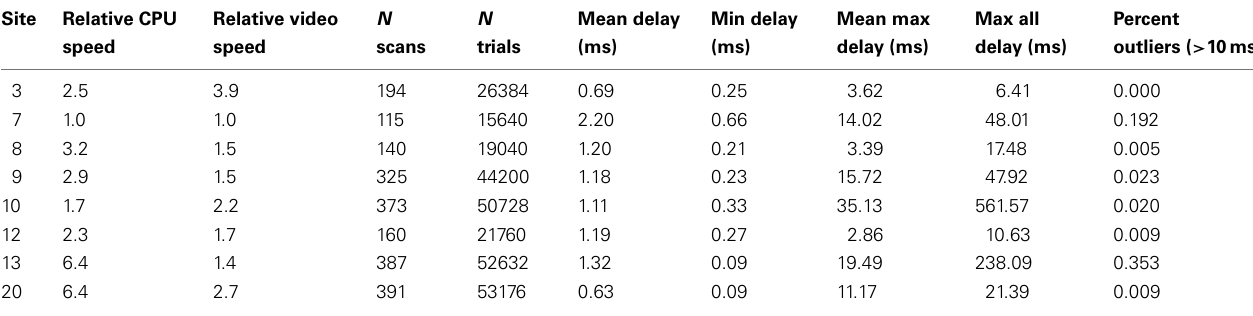
Table 2 | Comparison of stimulus timing accuracy across eight sites using the ObjWM task.